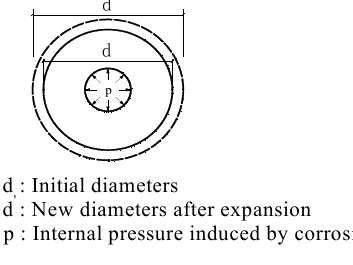
Figure 1. Mechanical model of reinforced concrete corrosion.